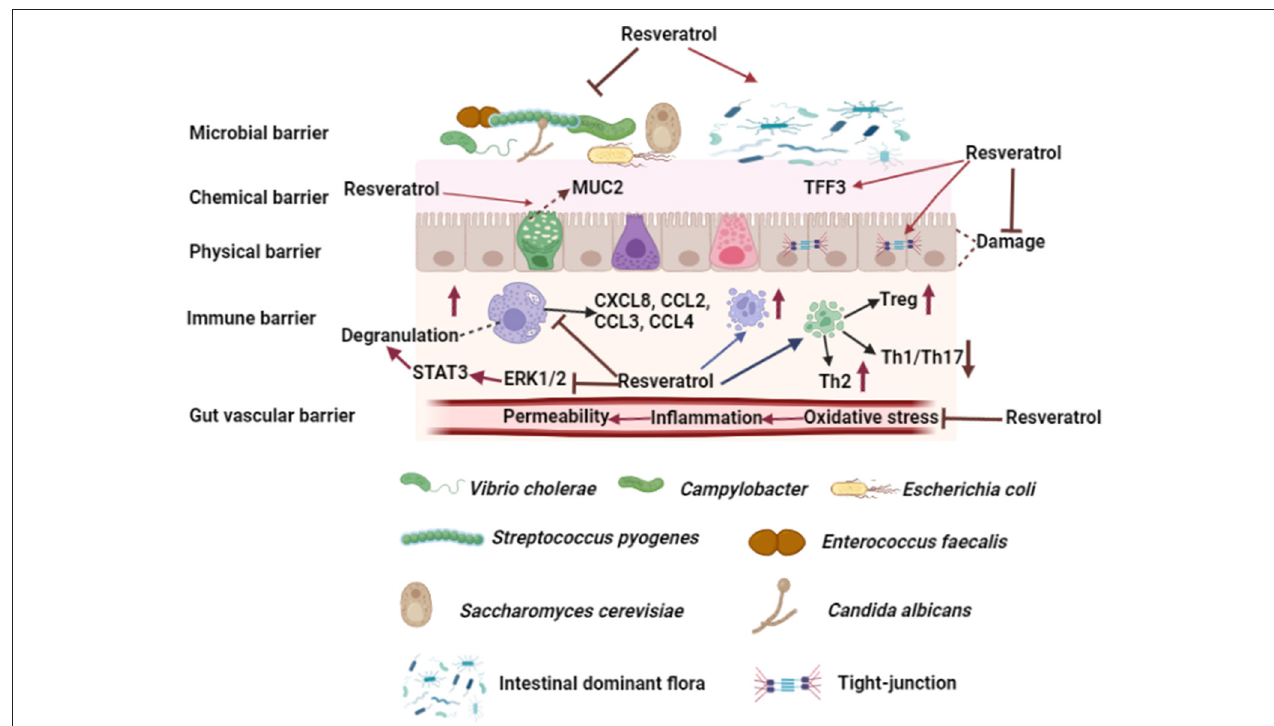
FIGURE 3 | Effects of resveratrol on intestinal barrier. Resveratrol could improve intestinal microbial barrier by inhibiting the growth of pathogens and modulating the composition of intestinal dominant flora. Resveratrol promotes goblet cells to secrete MUC2 and increases TFF3 in mucous layer. Moreover, resveratrol increases the expression of tight junction protein between enterocytes and protects enterocytes from injury. Resveratrol affects T cell differentiation and increases the number of Treg and Th2 cells in intestinal lymph nodes and lamina propria, while decreases the number of Th1 and Th17 cells. Furthermore, resveratrol increases the number of mast cells and macrophages in intestinal lymph nodes and lamina propria, and inhibits mast cell degranulation by inhibiting the phosphorylation of ERK1/2 and STAT3 and affecting mast cell chemokine secretion. Resveratrol improves gut vascular barrier by reducing vascular permeability. The figure was created with